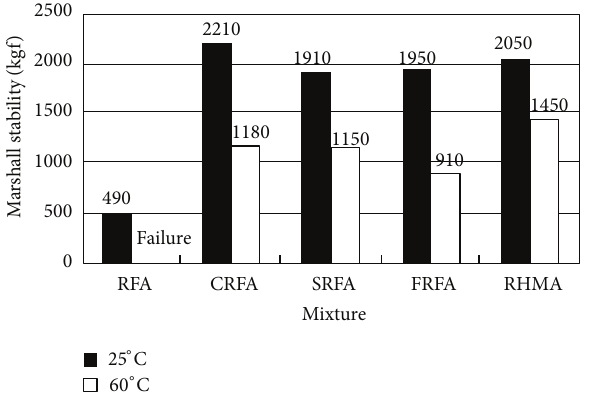
Figure 7: Indirect tensile strength test results and IDT ratio.